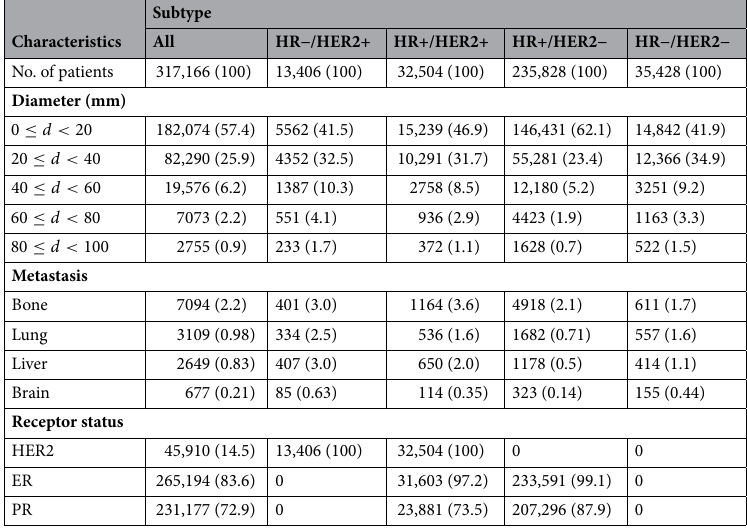
Table 1. Data characteristics. Number of patients within each subtype group with a given characteristic specified in the left column. The numbers in parenthesis show the parentage of patients relative to respective subtype